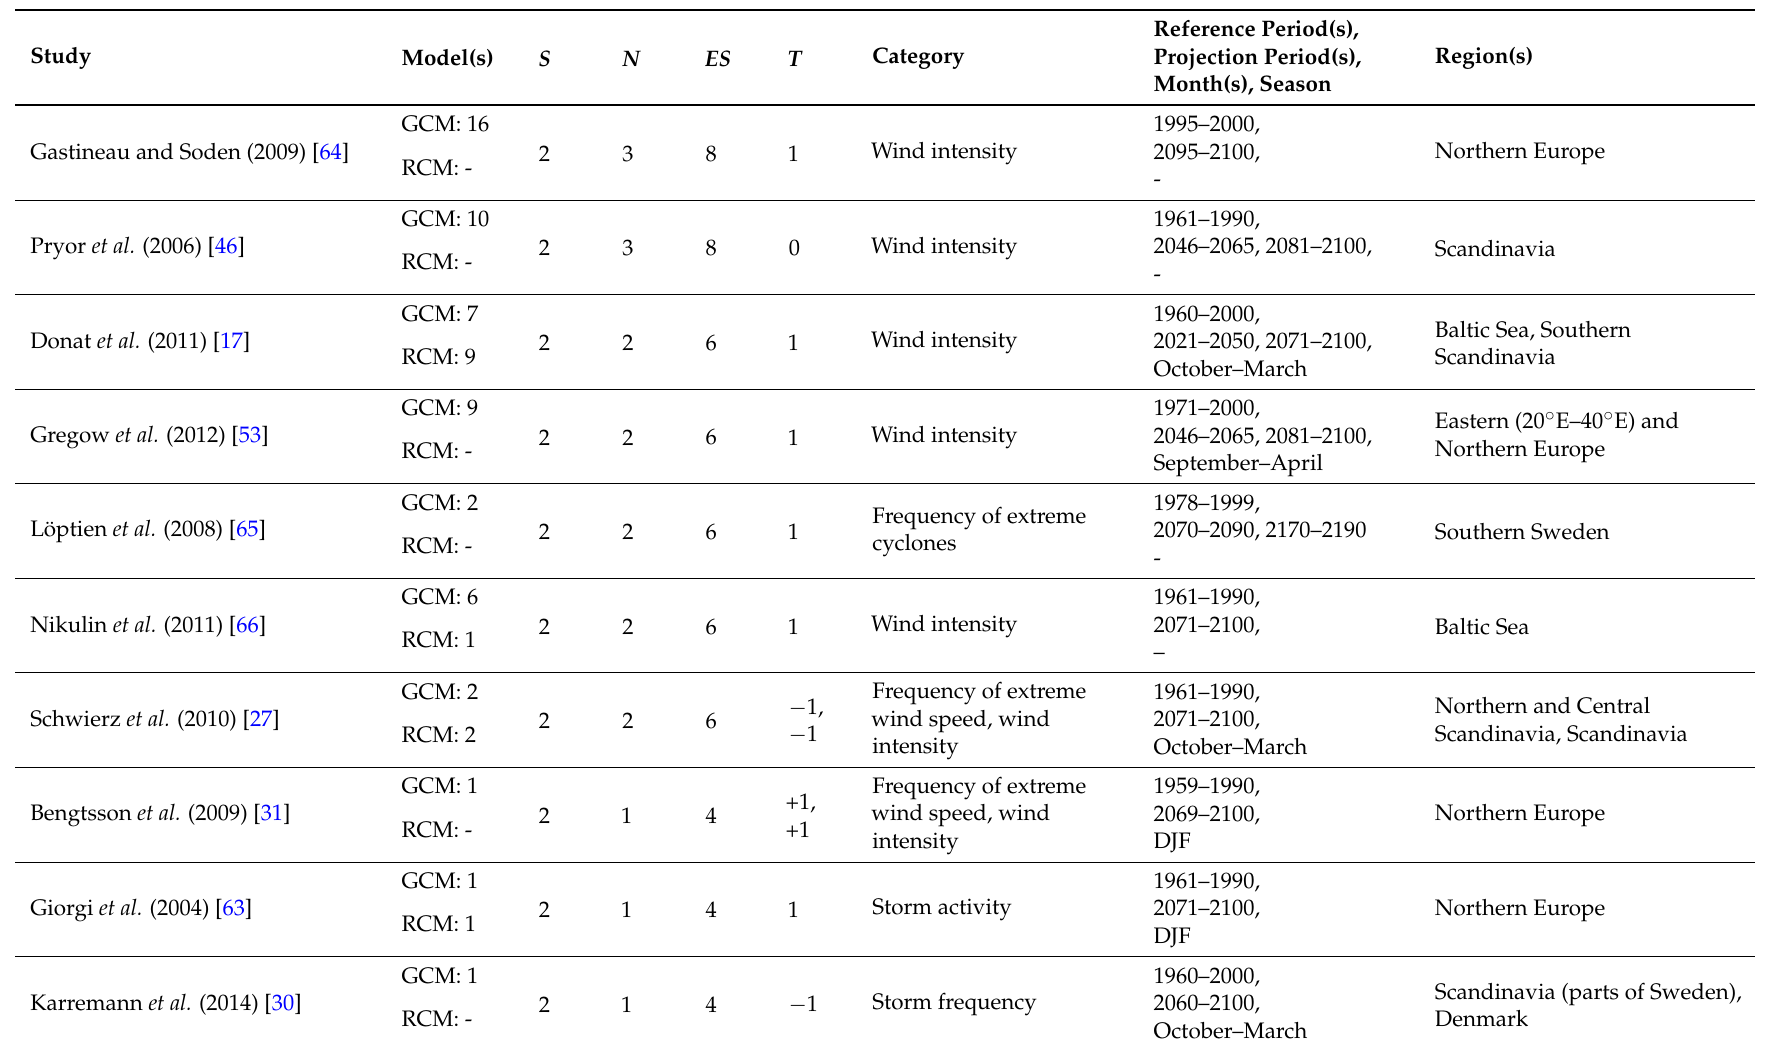
Table 3. Same as Table 1 but for the Northern Europe